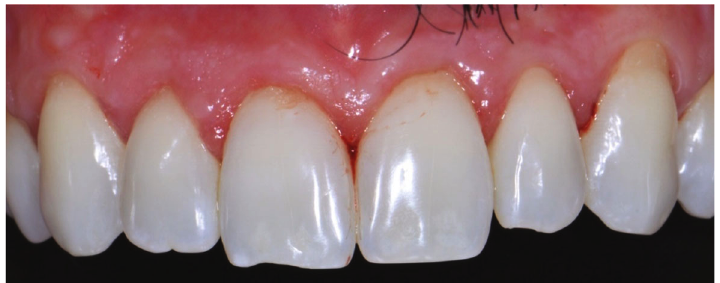
Figure 4: Postoperative follow-up after 30 months. Stable results along the time with minimal modi fi cations. Patient presented bleeding on probing and gingivitis that was further treated during the